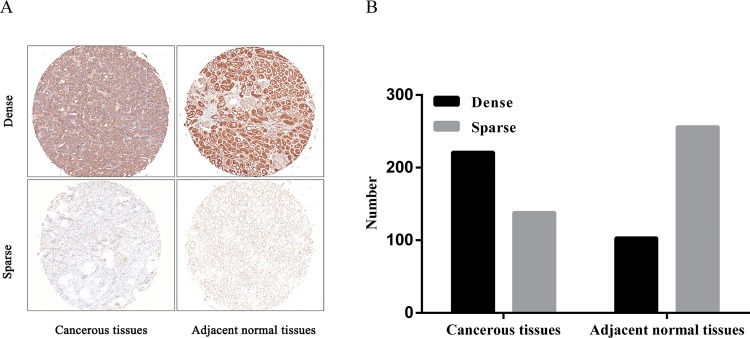
The distribution pattern and representative images of SCD1 High/low expression in tissues.A. Representative images of SCD1 staining with High/Low expression in ccRCC and adjacent normal tissues. B. The distribution pattern of SCD1 in ccRCC and adjacent normal tissues. Bar: 100 μm.